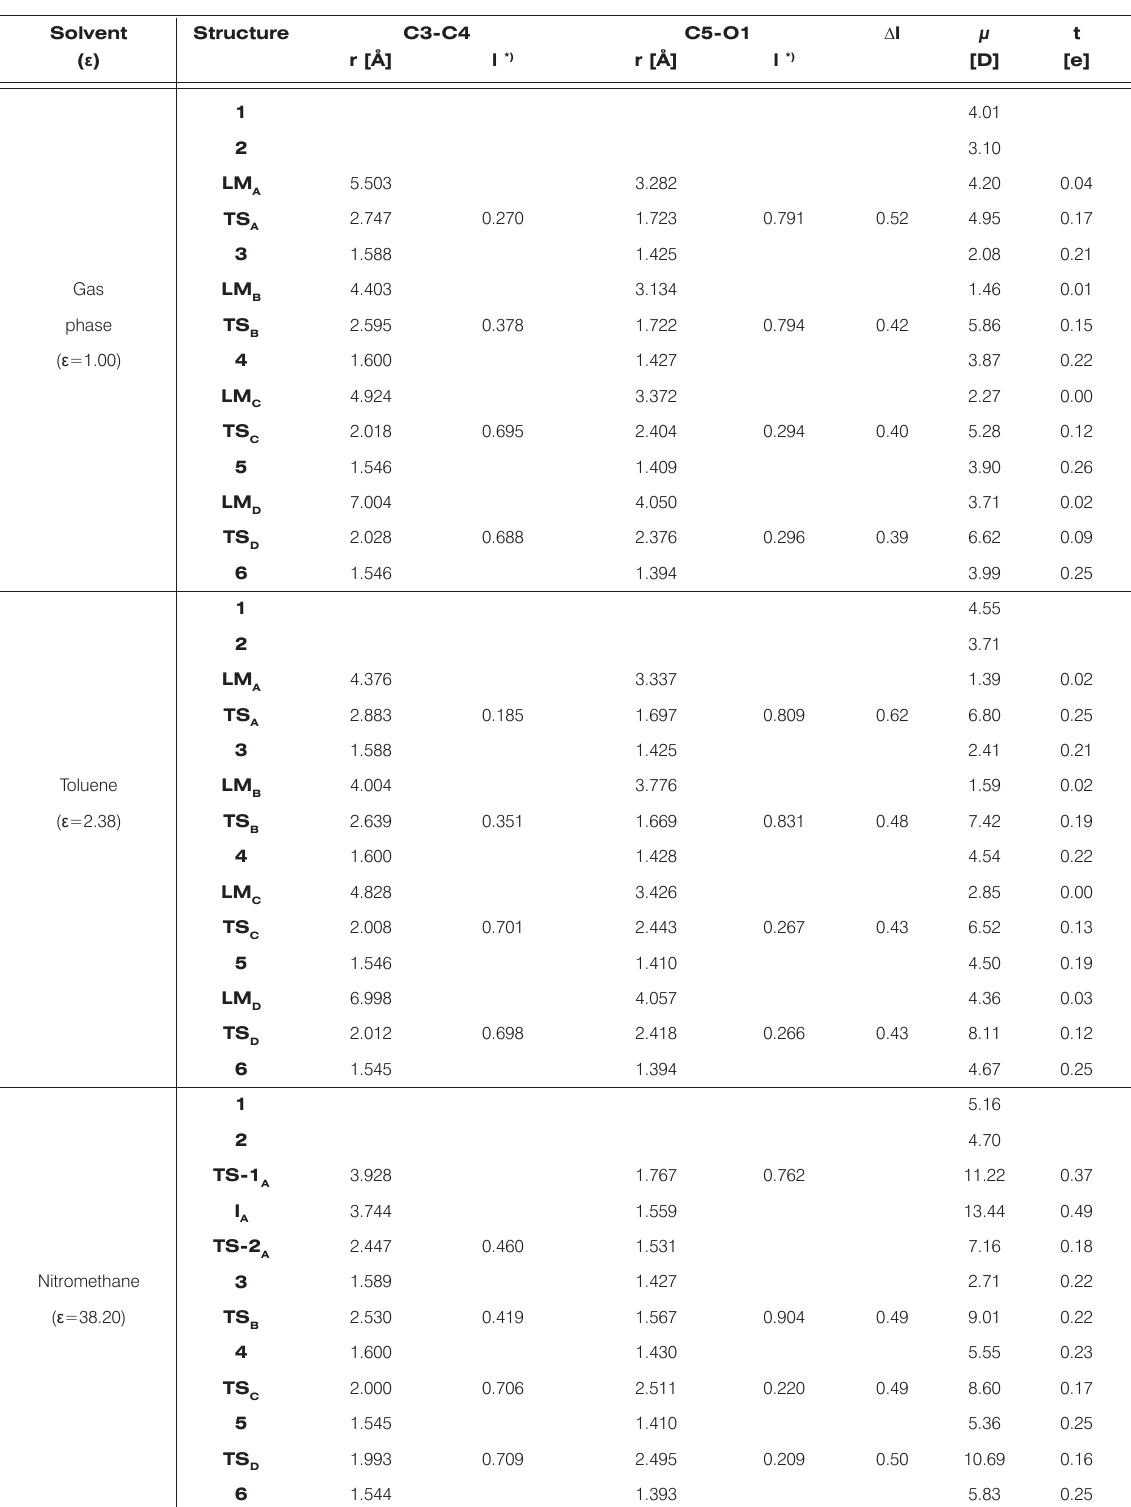
Table 3. Physical properties of critical structures of [2+3] cycloaddition between a -phenylnitroethene 1 and (Z)-C,N-diphenylnitrone 2 according to B3LYP/6-31G(d) calculations (T=298 K; ∆ H and ∆ G values are in kcal mol -1 ; ∆ S values are in cal mol -1 K -1 ). Solvent Structure